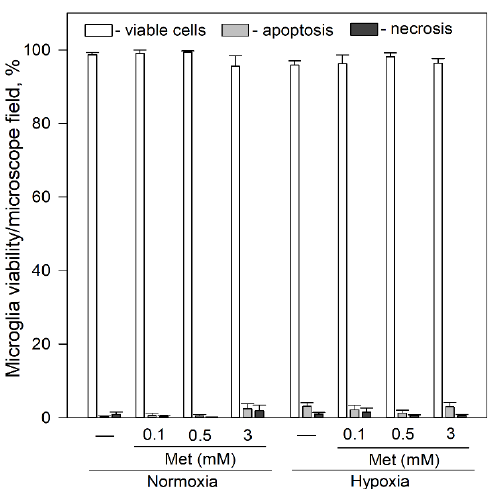
Figure 6. Effects of metformin on microglial cell viability after 24 h incubation under hypoxic and normoxic conditions. Cell viability was assayed as described in Methods section (Methods 4.4.). Met—metformin. Statistical comparison between the experimental groups were tested for normality using Shapiro–Wilk test and statistically compared between experimental groups by using One Way ANOVA using Tukey test. Each bar represents mean ± SE (N = 4 – 17 number of experiments on independent cell culture preparation).